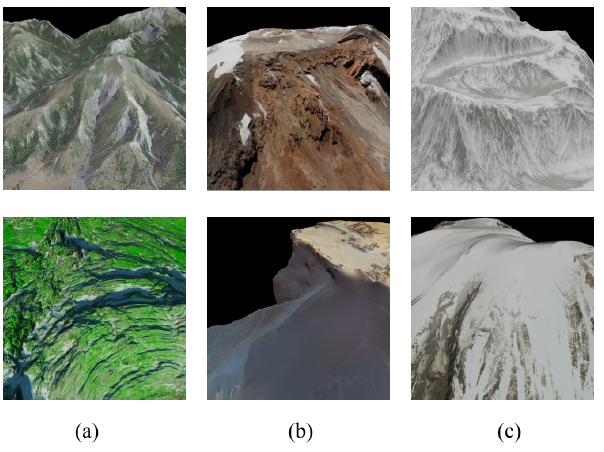
Figure 1. Different types of mountain areas: ( a ) vegetation-covered mountains, ( b ) rocky mountains, ( c ) snowy